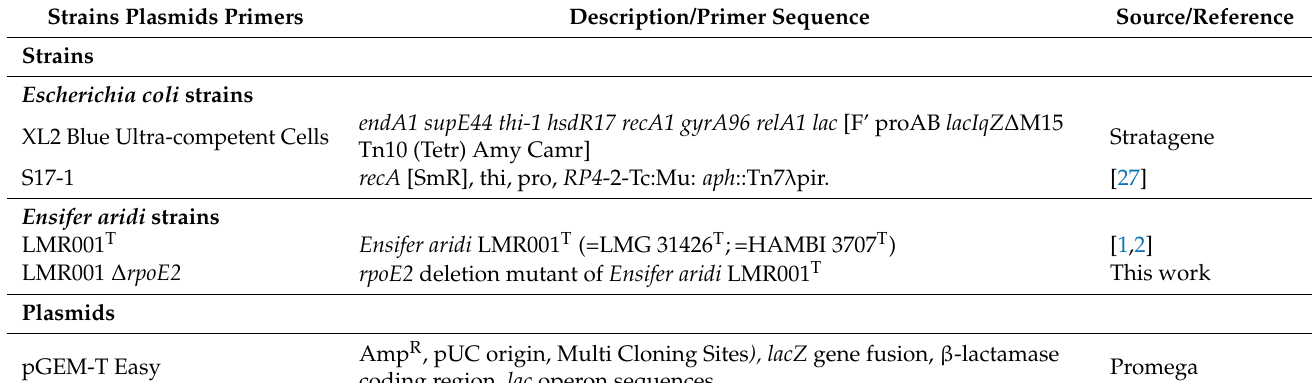
Table 1. Strains, plasmids, and primers used in the